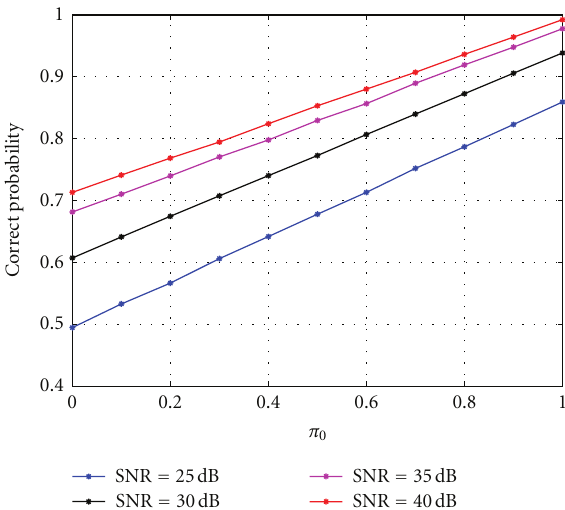
Figure 11: Simulated correct probability of the sensor network with an intermediate fusion helper under the AND combining rule for di ff erent π 0 values in Rayleigh fading channels ( A = 0 . 95, β = 3 . 5, d = 10, α = 0 . 5).